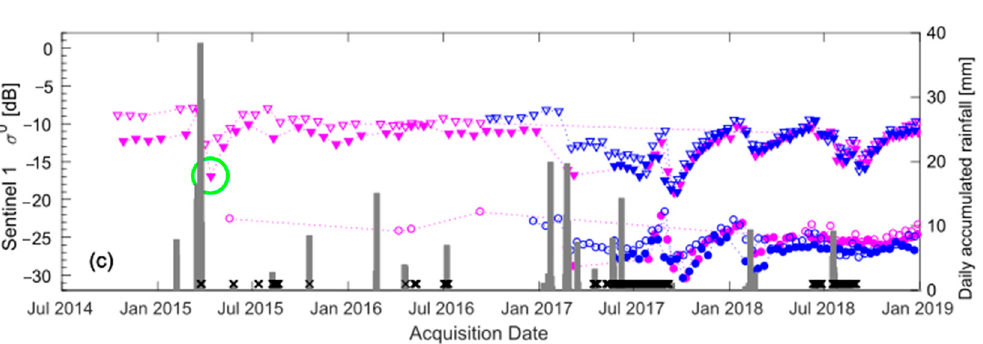
Figure 8. Sentinel 1 temporal backscattering observed over the salt pan. Sentinel 1A (magenta) and Sentinel 1B (blue) in ascending (full markers) and descending (empty markers) orbits. VV polarization is indicated as triangles, and VH are circles. The vertical black dashed line indicated a field visit on 3 April 2018 (see Figure 4). ( a ) Soft pan crust (site S1), the local incidence angle is between 35.2 ◦ –35.4 ◦ (ascending only), ( b ) Hard-pan crust 2 (S6), the local incidence angle is between 39.9 ◦ –40.1 ◦ (ascending), and 31.1 ◦ –31.3 ◦ (descending), ( c ) Hard-pan crust 1 (S10), local incidence angle is between 39.2 ◦ –39.3 ◦ (ascending), and 32.2 ◦ –32.3 ◦ (descending). Sentinel 1A VH polarization is available from February 2017. The green circles indicate episodic events: on 26 May 2017 for site S1 and on 13 April 2015 for sites S6 and S10. Daily accumulate rainfalls recorded at Socaire are in grey bars, and snowfall cover also shown as black